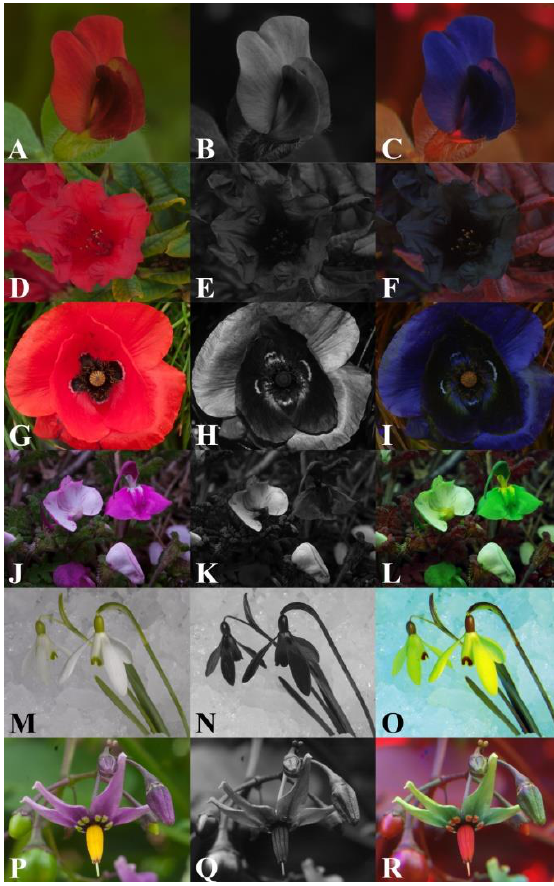
F IGURE 19. Colour pictures (left), UV-pictures (middle) and false-colour pictures (right) of Lotus tetragonolobus L. (A, B, C), Rhododendron forrestii B. Balfour ex Diels (D, E, F), Papaver rhoeas L. (G, H, I), Pedicularis gruina Franch ex Maxim. (J, K, L), Galanthus nivalis L. (M, N, O) Solanum dulcamara L. (P, Q, R).